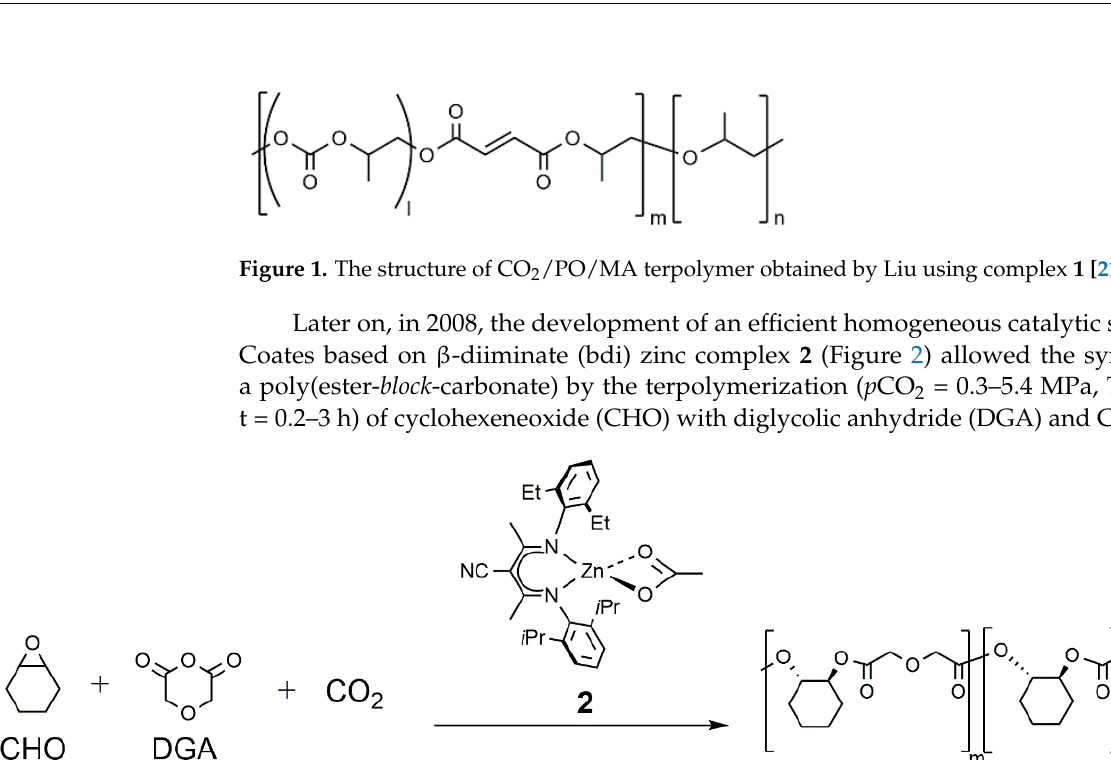
Figure 2. Terpolymerization of CHO, DGA and CO 2 with β -diiminate zinc complex 2 by Coates. Reproduced with modification and permission from ref. [22] . Copyright (2008) John Wiley and Sons.